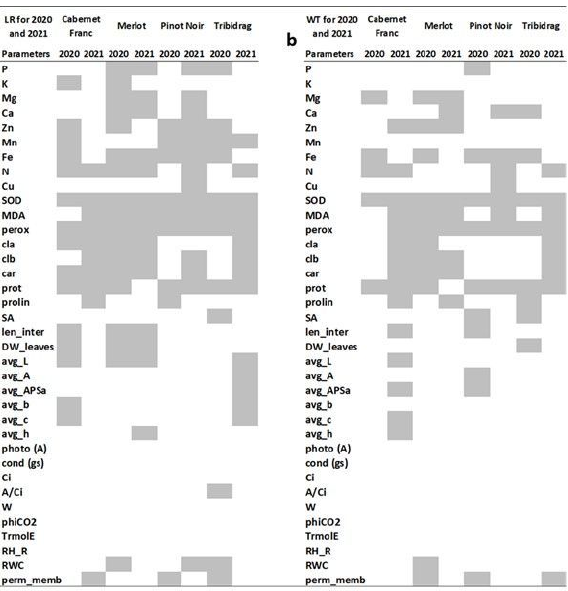
Figure 3. Summary of changed parameters according to ANOVA analyzed for leafroll (LR) genotypes in 2020 and 2021 ( a ) and wild-type (WT) genotypes in 2020 and 2021 ( b ) for every grapevine variety. Statistically significant ( p < 0.05) differences are signed in grey.